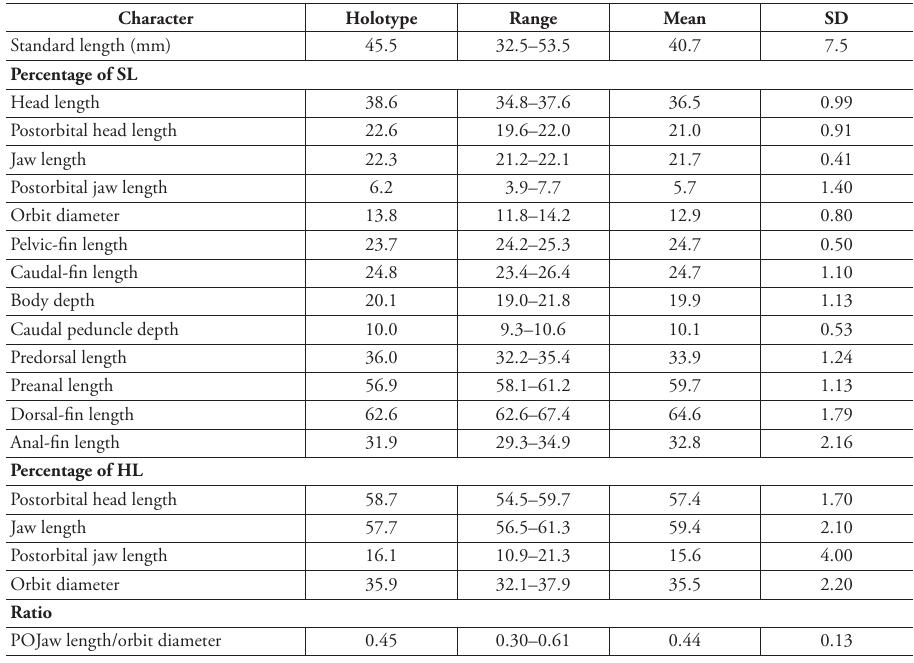
Table 3. Morphometric data for holotype and six paratypes of Opistognathus thionyi